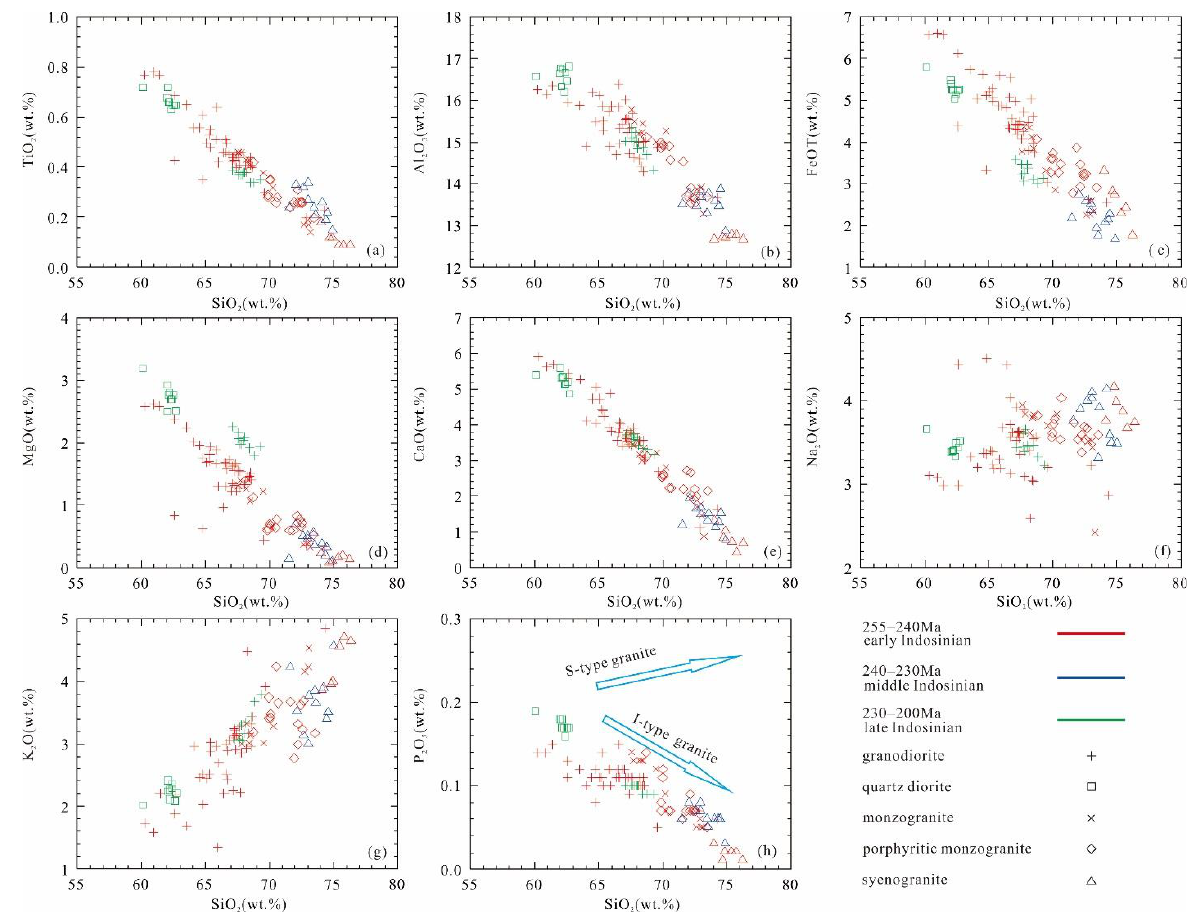
Figure 4. Harker diagrams for the Indosinian granite in the eastern region of the EKO. ( a ) SiO 2 vs. TiO 2 diagram; ( b ) SiO 2 vs. Al 2 O 3 diagram; ( с ) SiO 2 vs. FeOT diagram; ( d ) SiO 2 vs. MgO diagram; ( e ) SiO 2 vs. CaO diagram; ( f ) SiO 2 vs. Na 2 O diagram; ( g ) SiO 2 vs. K 2 O diagram; ( h ) SiO 2 vs. P 2 O 5 dia- gram.